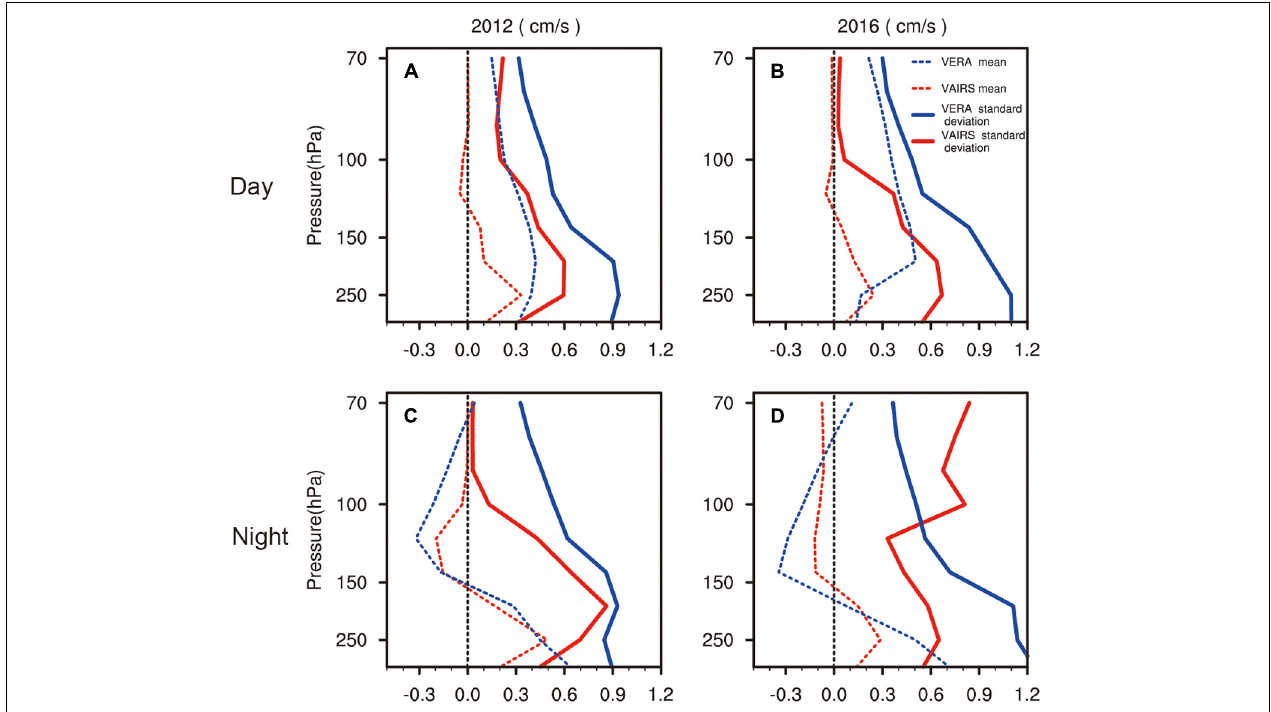
FIGURE 3 | Mean (dashed lines) and standard deviation (solid lines) of V AIRS and V ERA − I in JJAS (units: cm s − 1 ) in 2012 (A,C) and 2016 (B,D) . The blue lines are V ERA − I and the red are V AIRS . The upper panels are daytime and the bottom panels nighttime.